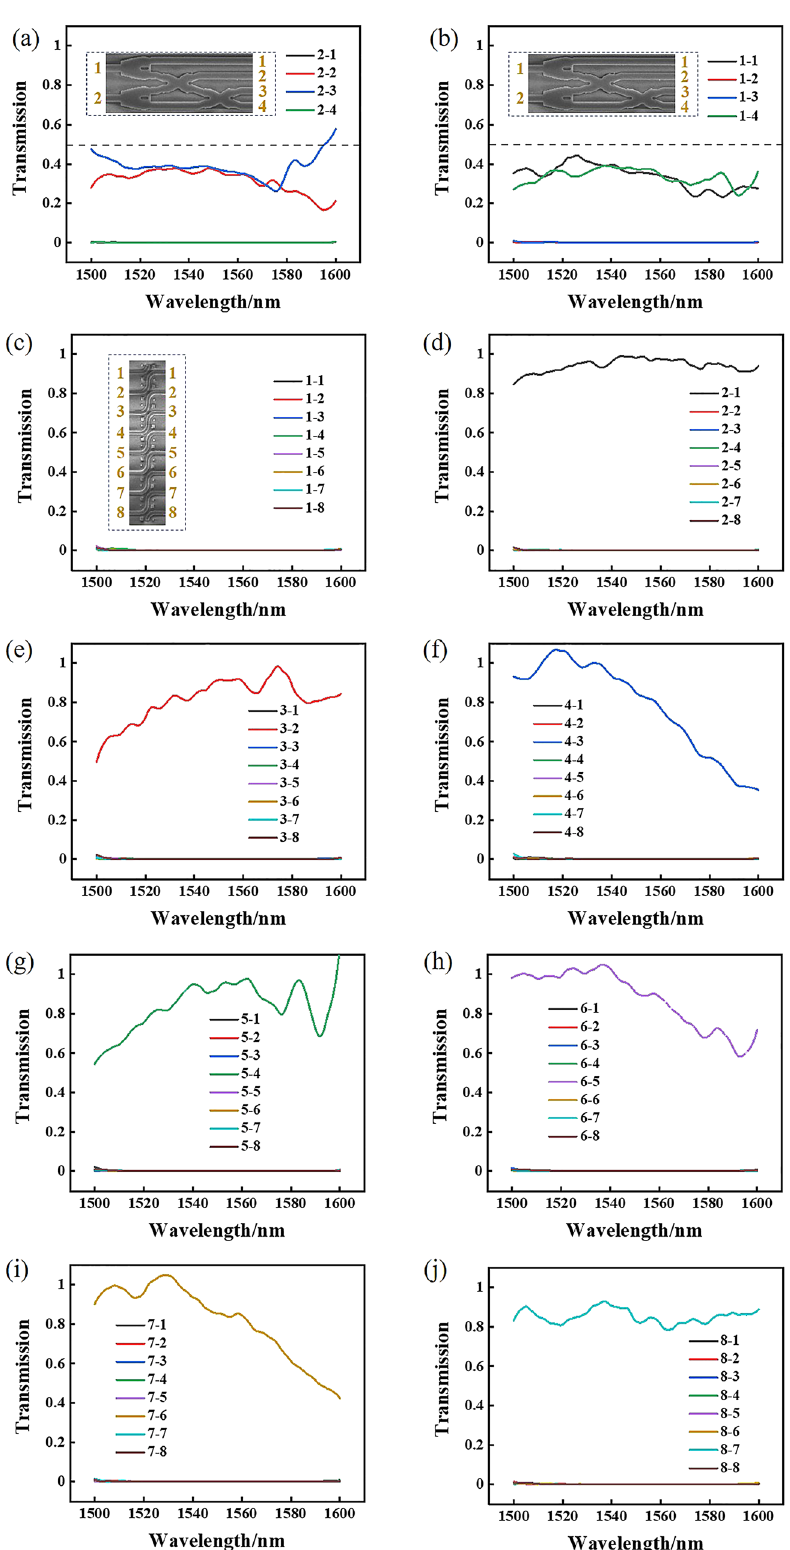
Figure8: Experimentresultsof thenormalized transmission of all-optical calculation